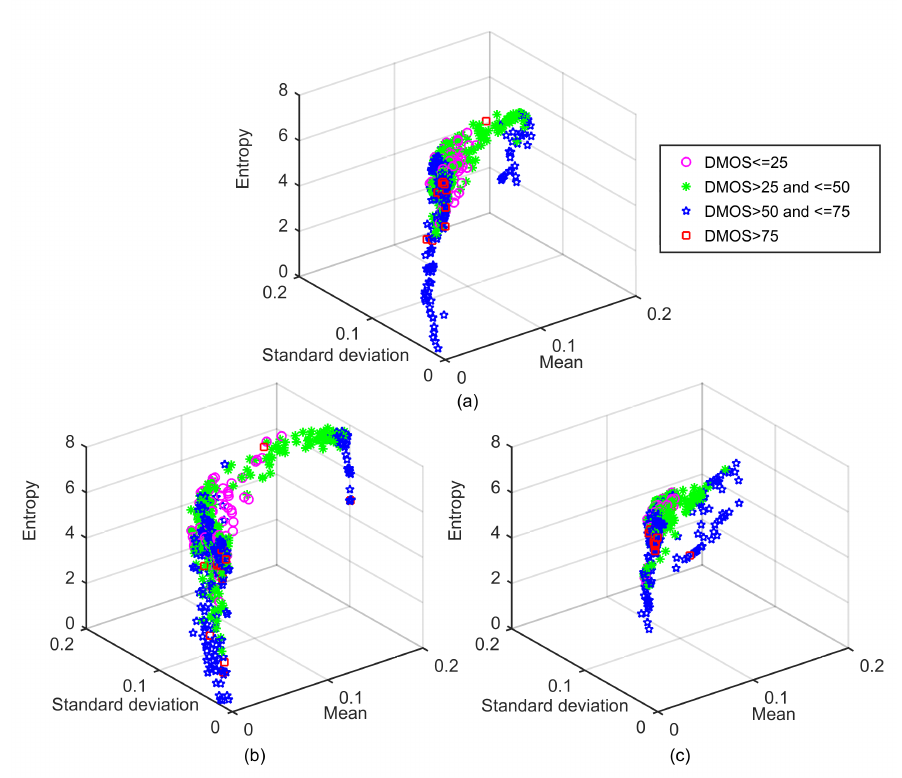
Figure 6. 3D scatter plots between the color features extracted from HSV color space on LIVE [28] database: ( a ) features in the saturation channel; ( b ) features in the hue channel; and ( c ) features in the value